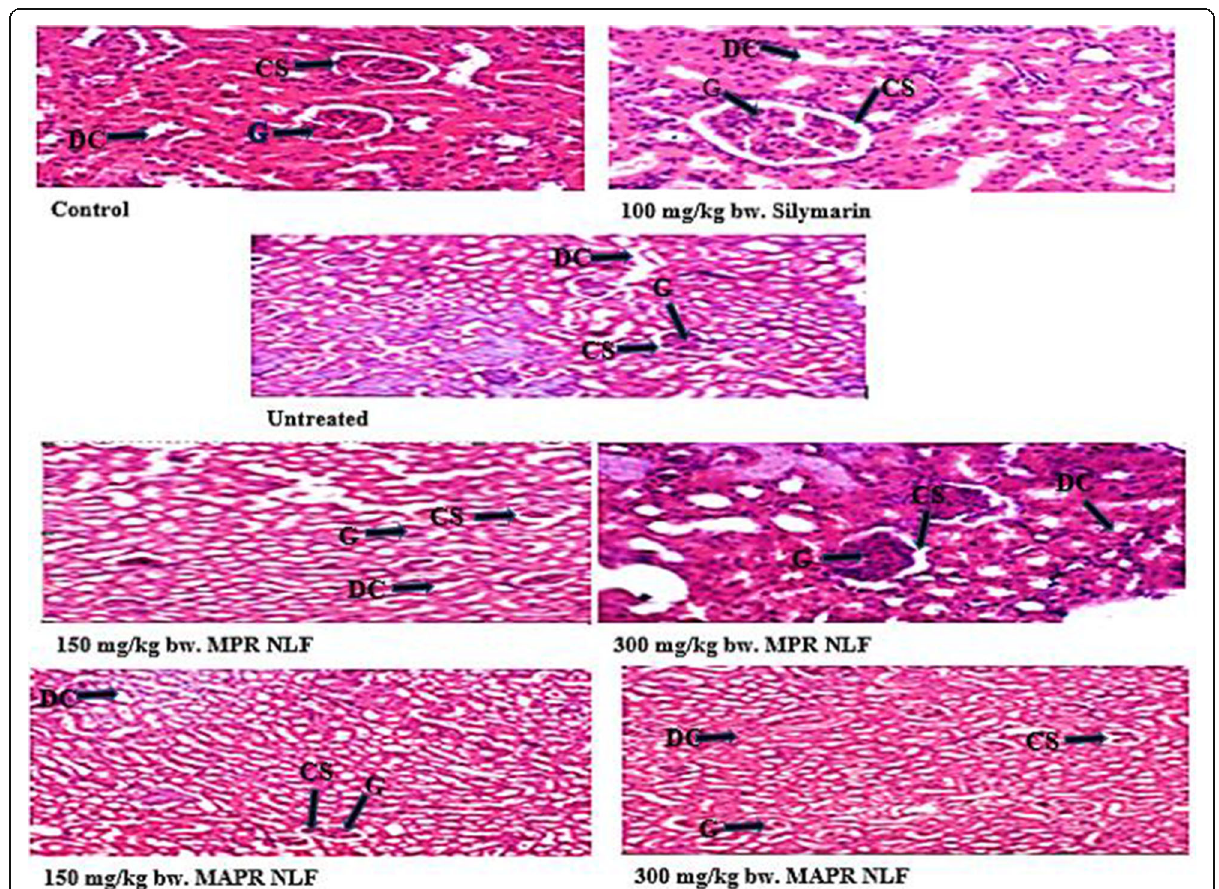
Fig. 2 Histology of the Kidney of male Wistar rats administered with lead acetate and treated with methanol and methanol/acetone phenolic- rich extract of N. latifolia fruit (Mg × 40; Eosin and Haematoxylin). G; Glomerulus, DC; Distal convoluted tubules, CS; Capsular